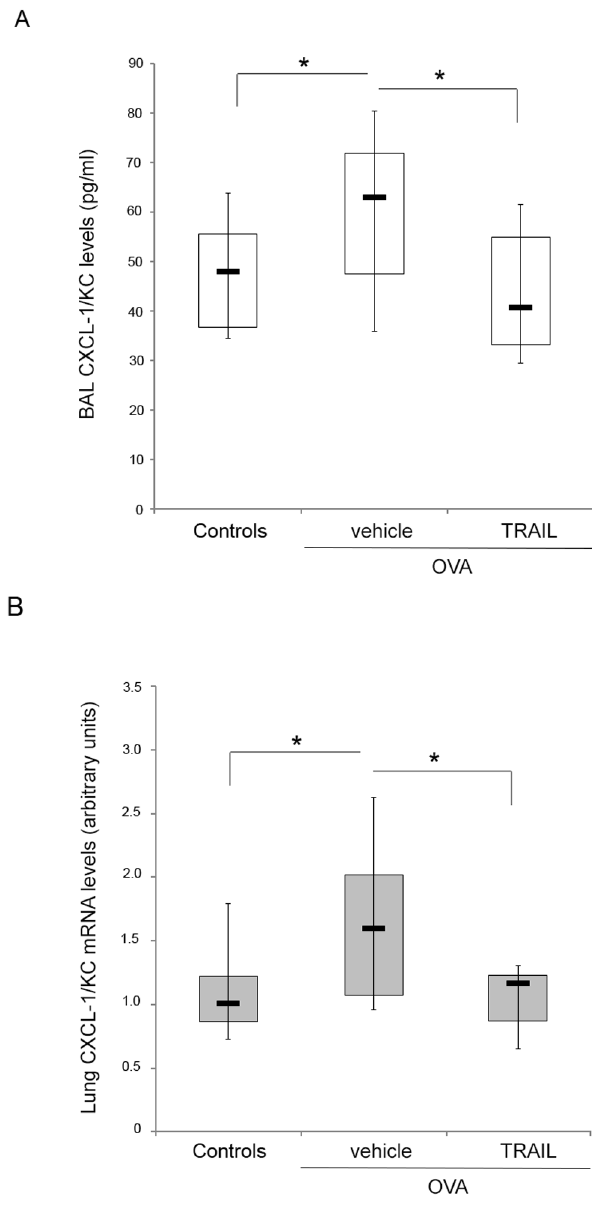
Fig. 4. Effect of recombinant TRAIL on OVA-induced CXCL-1/KC expression. In A , the levels of CXCL-1/ KC in the BAL fluids of Controls, OVA- and TRAIL + OVA-mice were measured by Multiplex assay. In B , the expression levels of CXCL-1/KC mRNA in lung tissue of Controls, OVA- and TRAIL + OVA-mice were determined by quantitative RT-PCR. Results from amplifications, done in duplicate, are expressed as arbitrary units after normalization for the housekeeping gene. In A–B , horizontal bars are median, upper and lower edges of box are 75th and 25th percentiles, lines extending from box are 10th and 90th percentiles; *, P , 0.05 (Mann-Whitney rank-sum